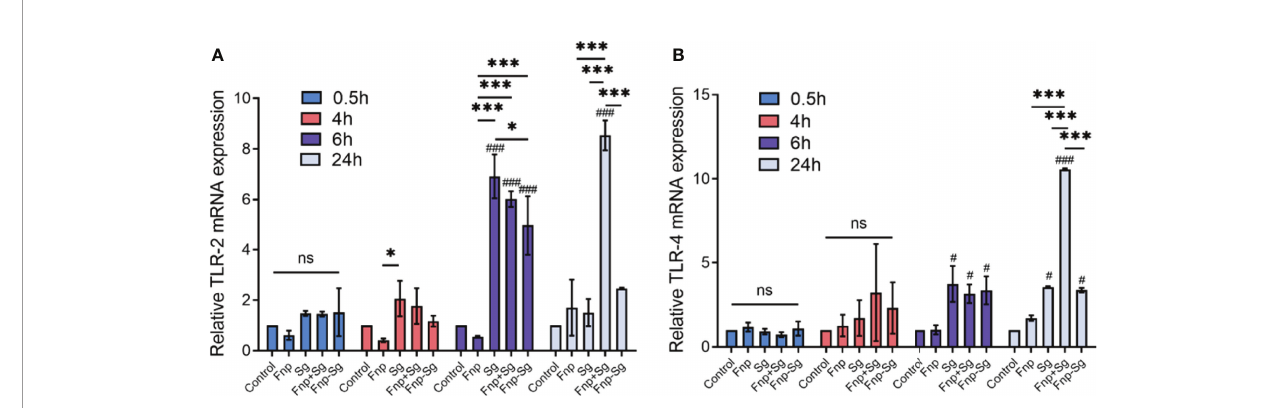
FIGURE 6 | TLR2 (A) and TLR4 (B) mRNA expression levels in hGECs infected with Fnp, Sg, Fnp+Sg and Fnp-Sg (* p < 0.05 , *** p < 0.001 , # compared with the control group, # p < 0.05 , ### p < 0.001 , ns: not statistically signi fi